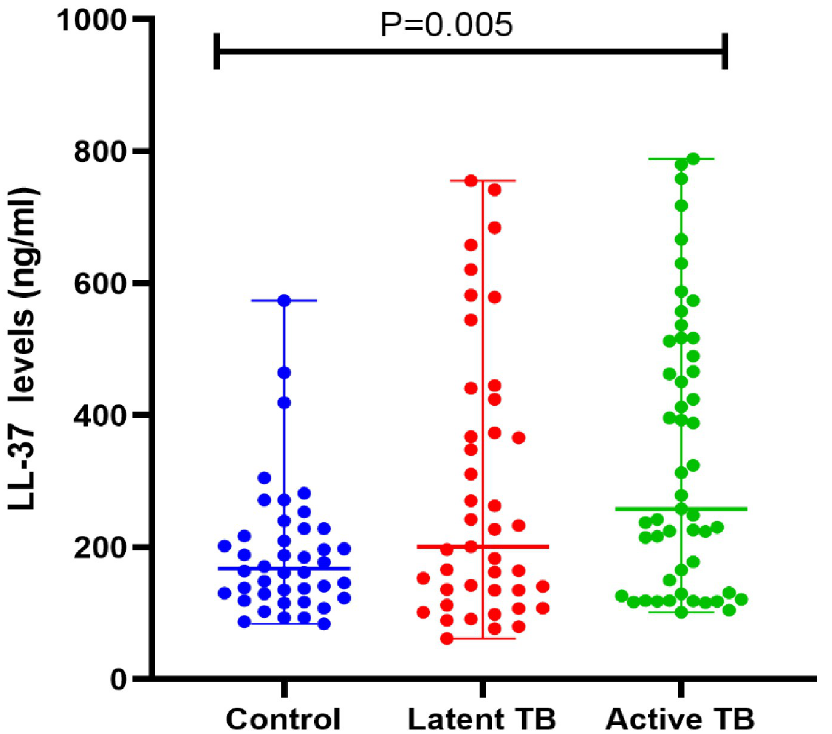
Fig 1. Distribution of serum LL-37 levels among active TB patients, LTBI individuals, and those without TB infection. Mann-Whitney; p = 0 0008 Active TB vs control, p = 0.1430 Active TB vs LTBI, p = 0.1374 LTBI vs control. N = 136. Each dot represents an individual. Median serum concentrations were significantly higher among the active TB patients compared to the latent and non TB individuals. p values are performed by Mann -Whitney test.